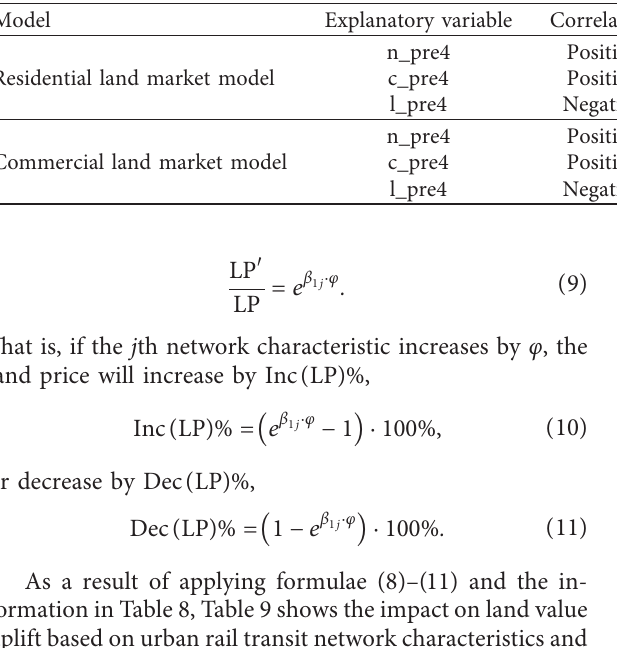
Table 9: The results of the hypothesis